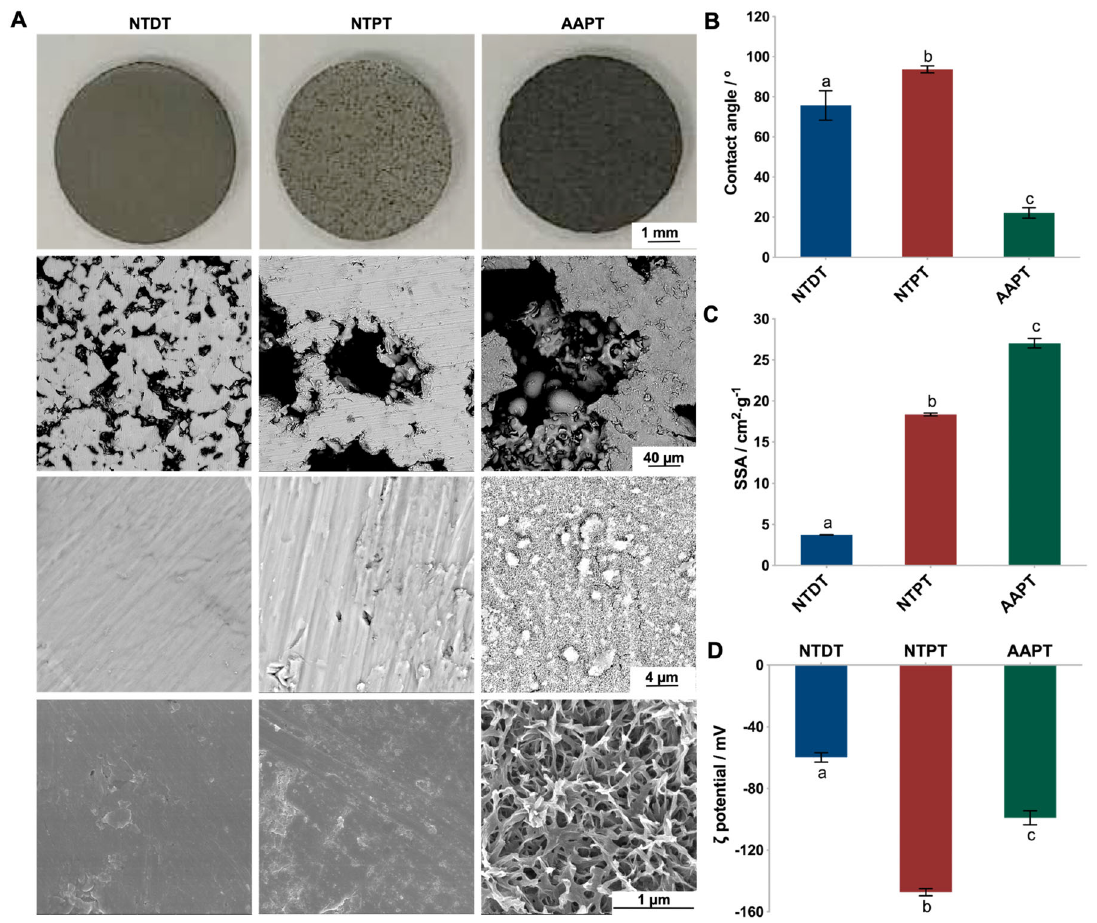
Fig. 1 Surface characteristics of Ti with or without surface treatment. A The surface topography of NTDT, NTPT and AAPT was observed by SEM, with AAPT showing needle-like submicropores and nanopores ( n = 3). B Contact angles were measured by the sessile-drop test ( n = 6). C SSAs of samples were determined by the BET method ( n =